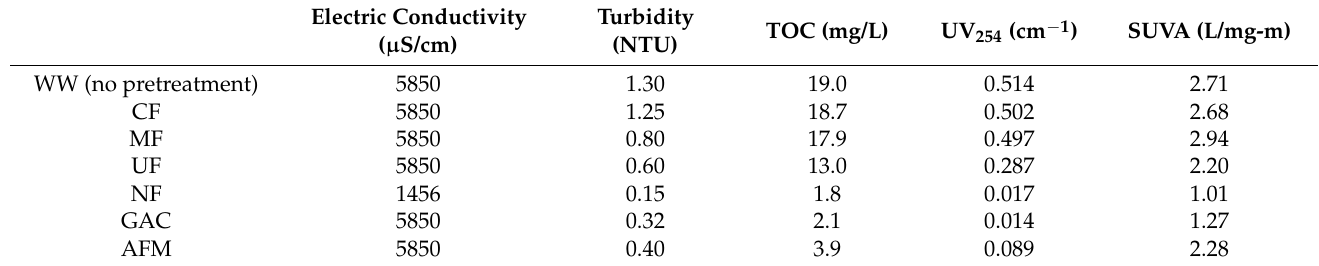
Table 4. Water quality of raw feed water (WW) and pretreated water.